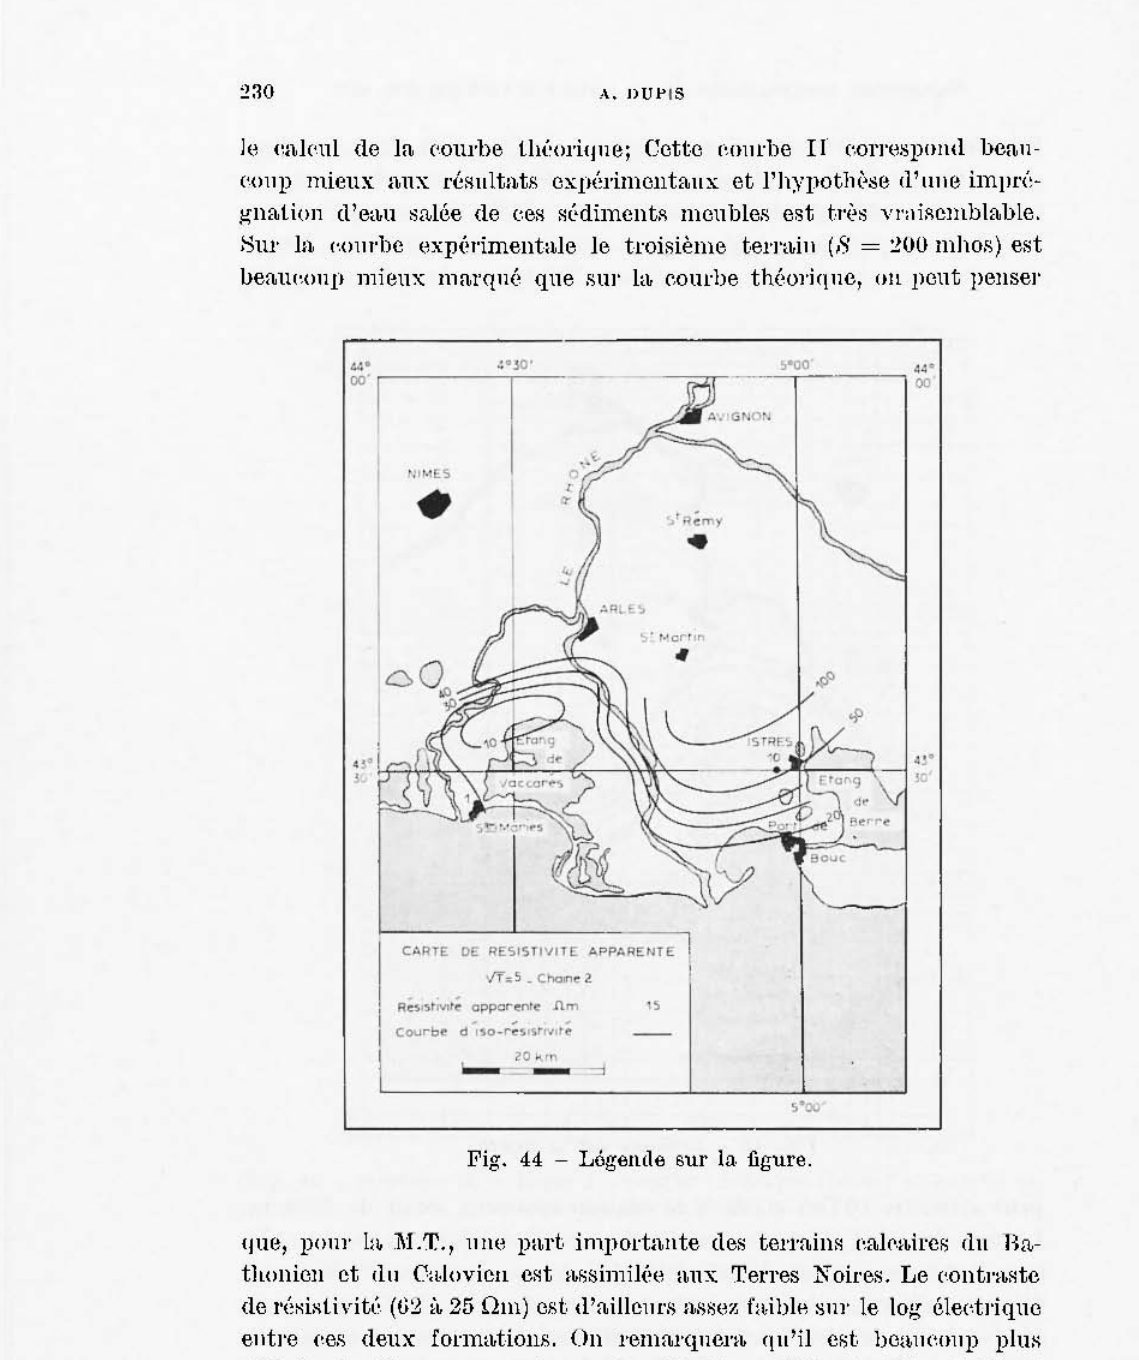
Pig. 44 - LOgellde BUl' la.